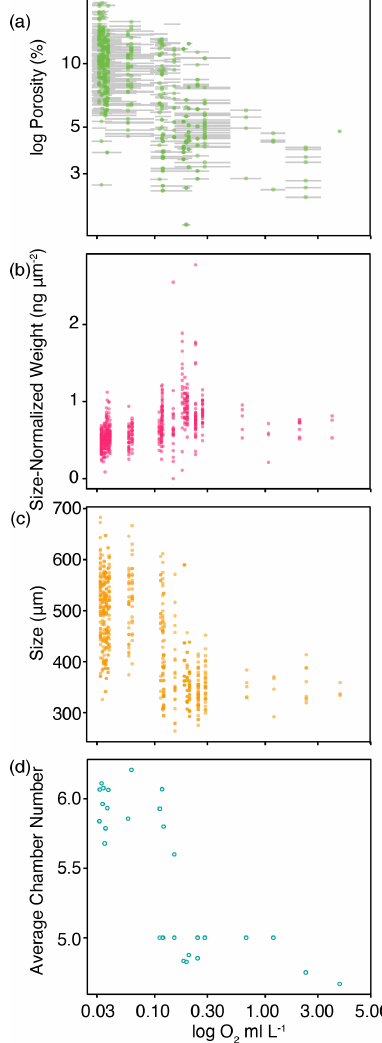
Figure 9. Morphological traits of G. hexagonus tests plotted against the average dissolved oxygen (log scale) measured in the nets in which they were collected. The depicted characteristics are (a) log of porosity, (b) size-normalized weight (using the area–density method), (c) size as measured by the longest dimension, and (d) the average number of chambers in the final whorl in a tow. Horizontal gray bars in (a) show the range of oxygen measured for each